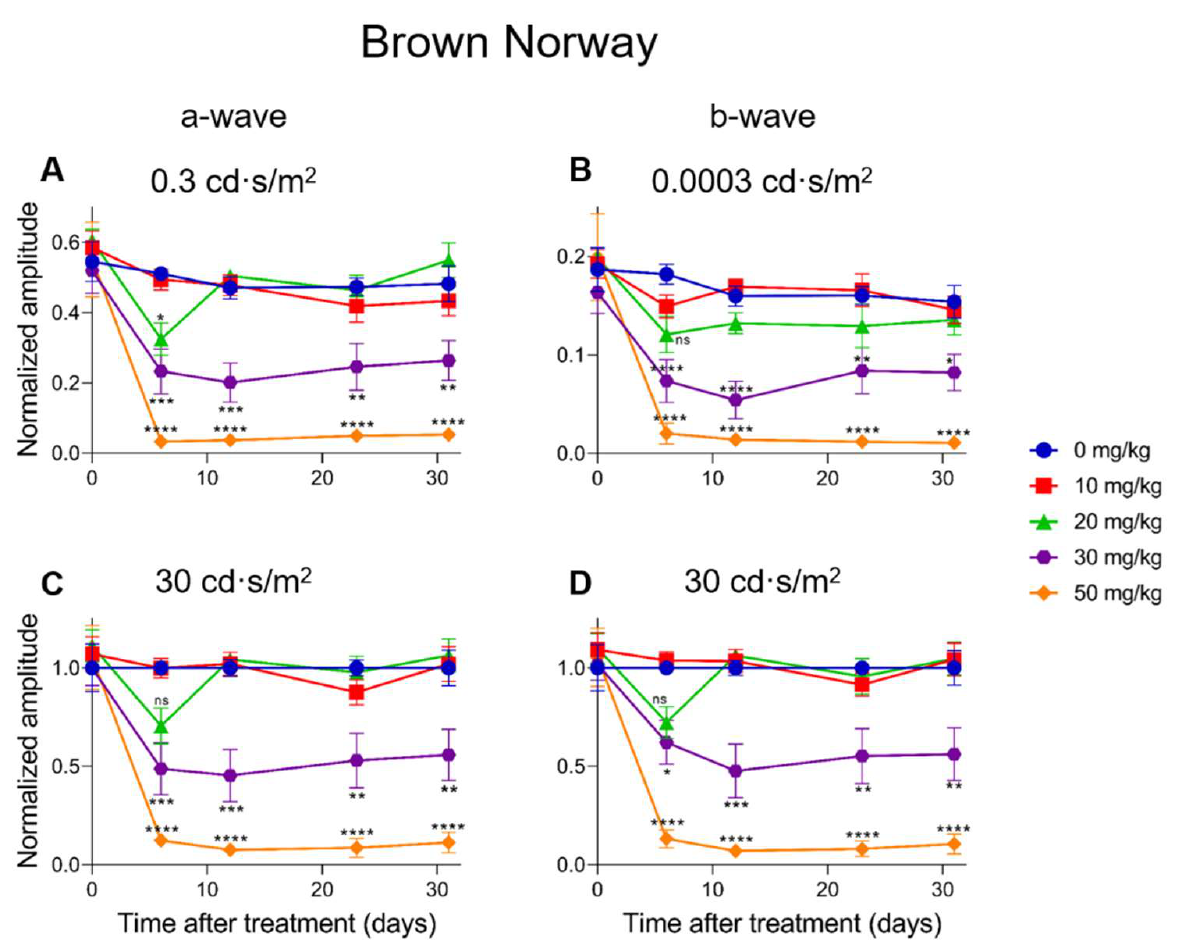
Figure 8. The normalized a-wave ( A , C ) and b-wave ( B , D ) amplitudes are plotted versus the time after treatment for all treatment groups in Brown Norway rats ( n = 4 per group). The amplitudes are shown measured at 0.3 cd · s/m 2 and 30 cd · s/m 2 (a-wave) and 0.0003 cd · s/m 2 and 30 cd · s/m 2 (b-wave) including the standard deviations. No significant effect was observed for the 10 mg/kg group compared to the control. Although not always significant, a temporary effect and significant for the a-wave amplitude at 0.3 cd · s/m 2 was seen for the 20 mg/kg treatment group. This effect was not observed anymore later in the experiment. From seven-days post-injection onwards, significantly decreased responses were observed for all the other treatment groups. The effects of the 30 mg/kg group were moderate for both the a- and b-wave amplitudes at all light intensities. A tremendous effect was seen for the higher treatment group (50 mg/kg). From one-week post-injection onwards, the recorded a- and b-wave amplitudes decreased to less than 10% of the original value. ns: not significant, *: p ≤ 0.05, **: p ≤ 0.01, ***: p ≤ 0.001, and ****: p ≤